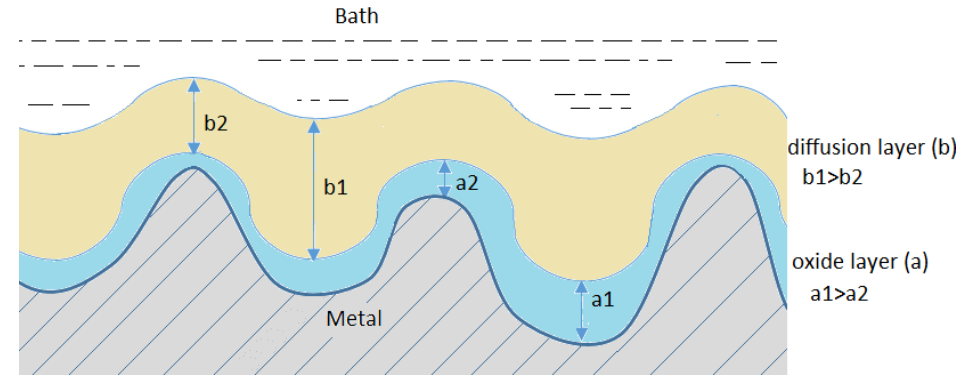
Figure 2. Mechanisms of the electropolishing processes.